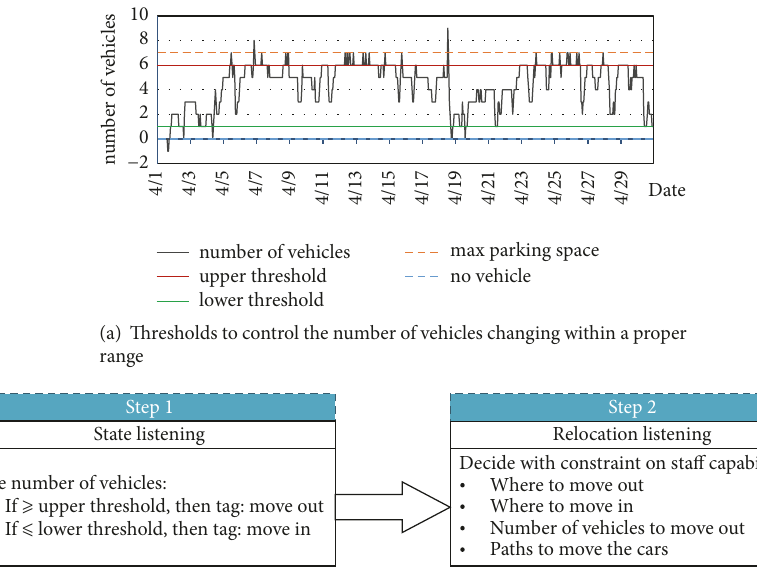
Figure 1: The threshold based relocation